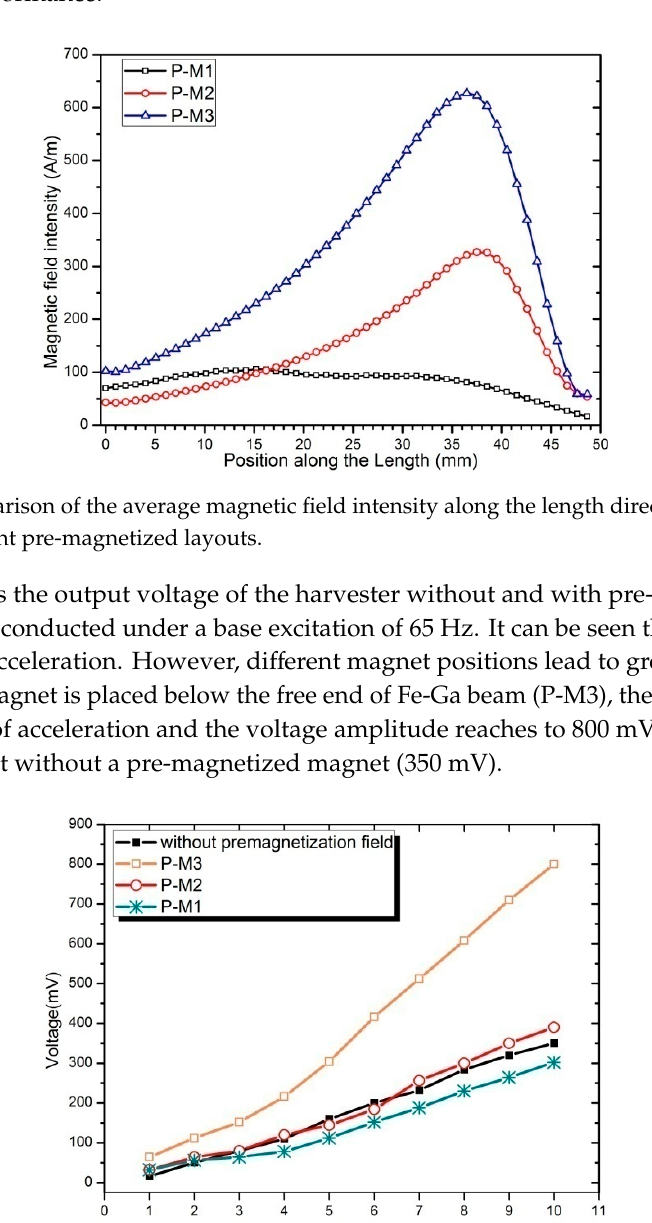
Figure 18. Voltage of the harvester without and with pre-magnetized magnet.